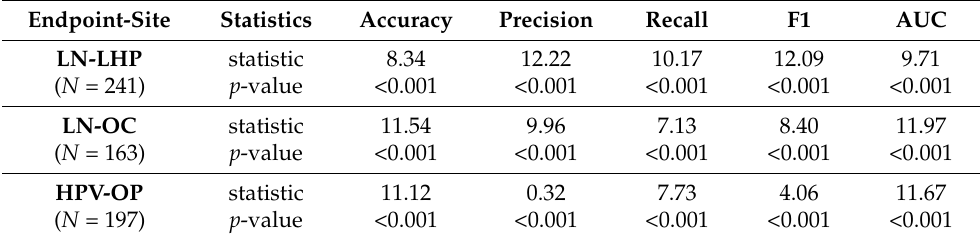
Figure 4. Clustering of texture features from three different anatomical locations (LHP: larynx or hypopharynx; OC: oral cavity); OP: oropharynx) using t-SNE with a perplexity value of 30. Table 4. The results of Wilcoxon rank-sum tests for comparing the performance of RF (Random Forest) models when all tumor sites were combined and used for model development (scenario 2) versus when only samples from one tumor site were used for model development (scenario 1). LN-LHP: lymph node metastasis prediction using features from larynx or hypopharynx sites; LN-OC: lymph node metastasis prediction using features from oropharynx site; HPV-OP: human papilloma virus status prediction using features from oropharynx